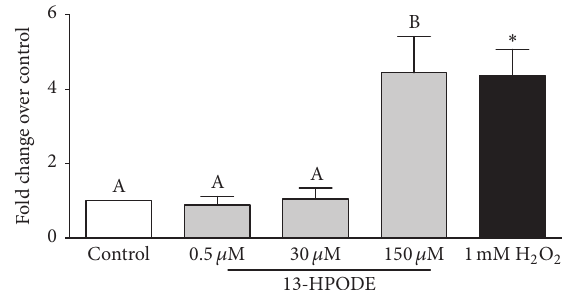
Figure 7: Mean change in caspase-3/7 activity of BMEC displayed as fold change over media control (open bar) after 6hr 13-HPODE (light grey bars) or 1mM H 2 O 2 exposure for 6hr (black bar, pos- itive control). Different letters demonstrate a significant difference among media control and 13-HPODE treatments determined by one-way ANOVA with Tukey’s post hoc correction. An asterisk ( ∗ ) represents a significant difference between medial control and H 2 O 2 as determined by Student’s t -tests. Significance declared at 𝑃 ≤ 0.05